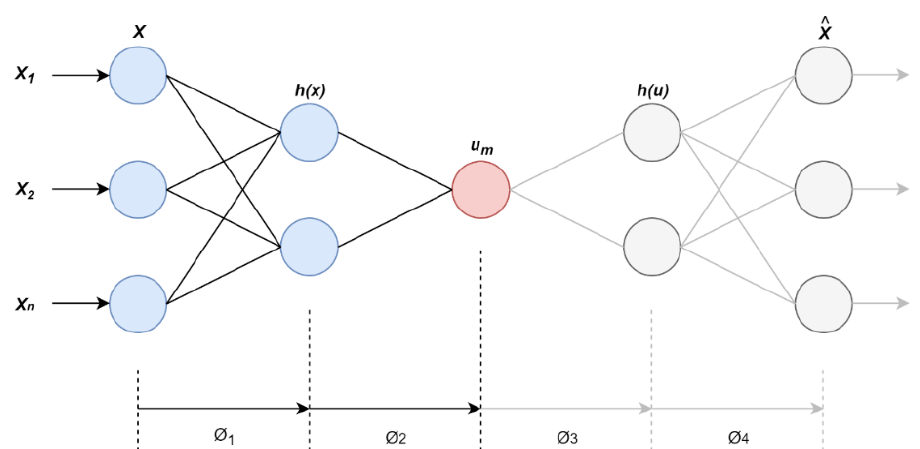
Figure 2. Diagram of non-linear principal component analysis (NLPCA) with a (3-2-1-2-3) network topology. This diagram shows 3 "hidden" layers of "neurons" (indicated by circumferences) inserted between the input layer 𝑥 on the left and the output layer 𝑥̂ on the right. h(x) is the encoding layer, u is the bottleneck layer and h(u) is the decoding layer. 𝜙1 , 𝜙2 , 𝜙3 , and 𝜙4 are the transfer functions. Adapted from Kenfack et al. [49].